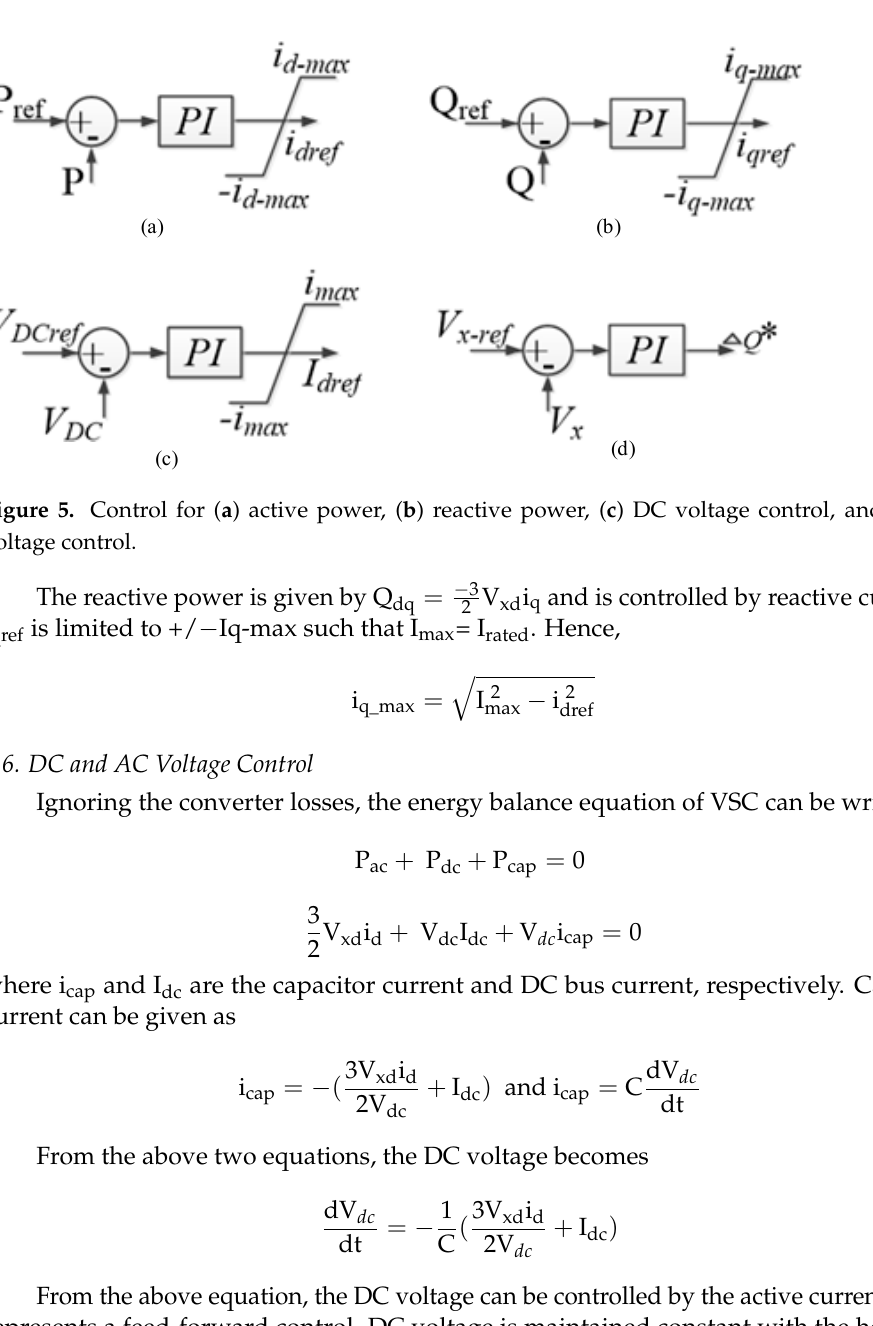
Figure 4. Inner current controller diagram.